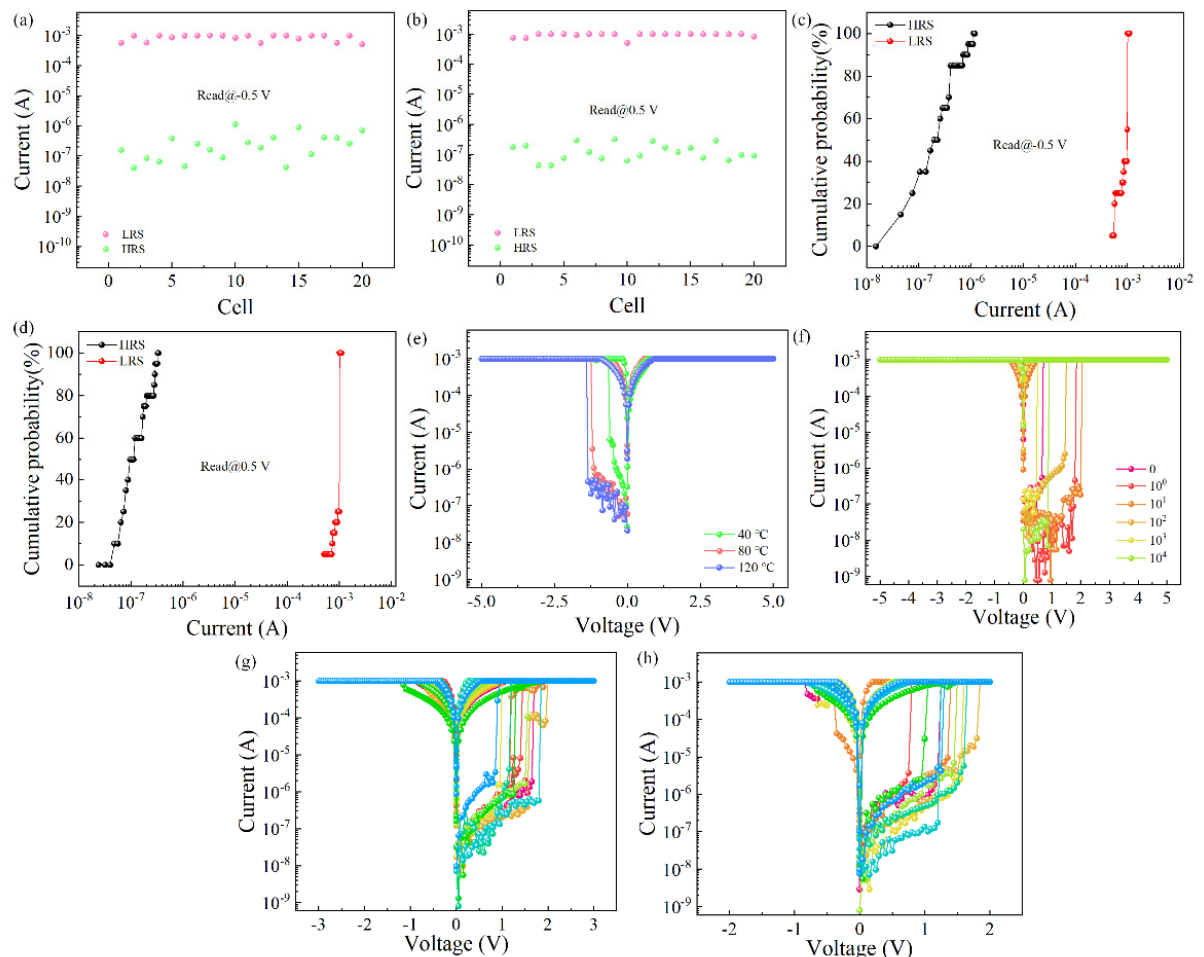
Figure 3. Yield rate of the Al/Gelatin:GQD/Al/PET device: ( a ) initial negative voltage applied; ( b ) initial positive voltage applied to the I-V characteristic curve of the Al/gelatin:GQD/Al/PET device. ( c ) Resistance accumulation probability at − 0.5. ( d ) Resistance accumulation probability at − 0.5. ( e ) Different drying temperatures. ( f ) Different bending times. ( g ) Scanning voltage 3 V~ − 3 V. ( h ) Scanning voltage 2 V~ − 2